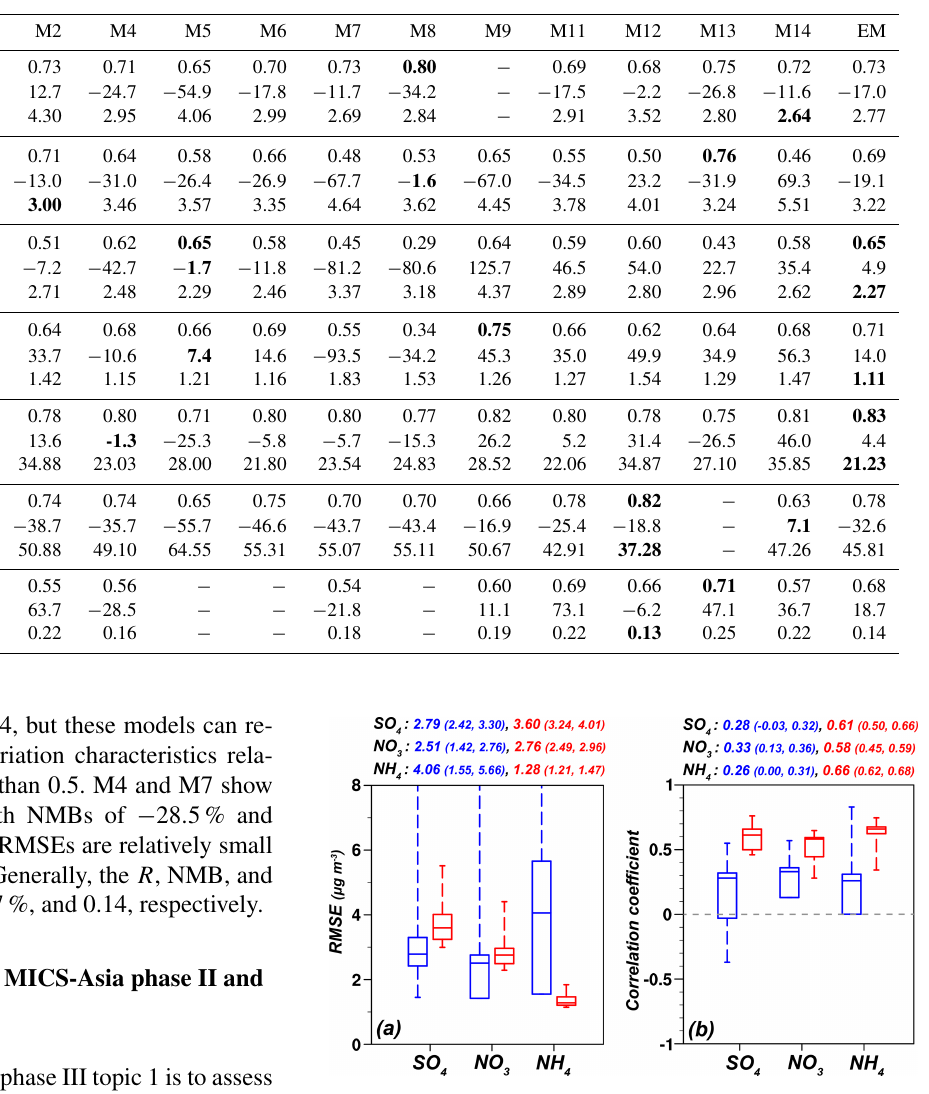
Figure 8. Intercomparison of model performance between MICS- Asia phase II (blue) and phase III (red) for SO 2 − Detailed information about the observations and simulations used in phase II can be obtained from Hayami et al. (2008). Each box plot exhibits the full range, the interquartile range, and the median for the (a) RMSE and (b) correlation coefficient. Detailed values of the median (the 25th percentile, the 75th percentile) are also listed above each